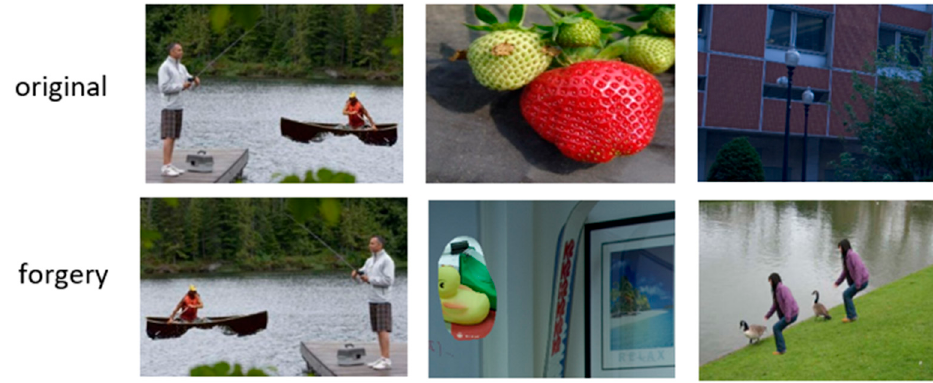
Figure 4. Samples of datasets CASIA v1.0, CASIA v2.0, and CUISDE.